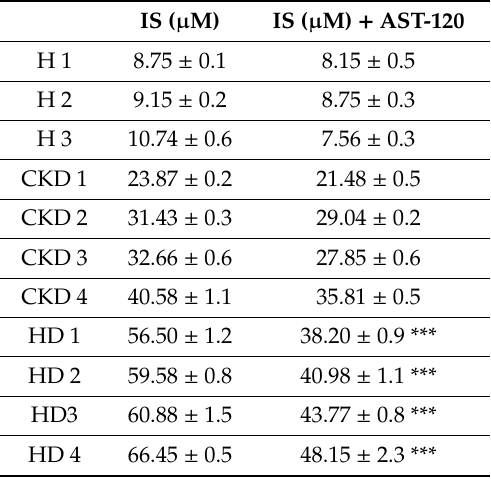
Table 1. IS concentrations in sera from 11 subjects: sera from three human healthy people (H1, H2, H3), sera from four CKD patients (CKD1, CKD2, CKD3, CKD4) and sera from four CKD dialysed patients (HD1, HD2, HD3, HD4); with or without AST-120 treatment. *** denotes p < 0.001 vs. serum alone. IS ( µ